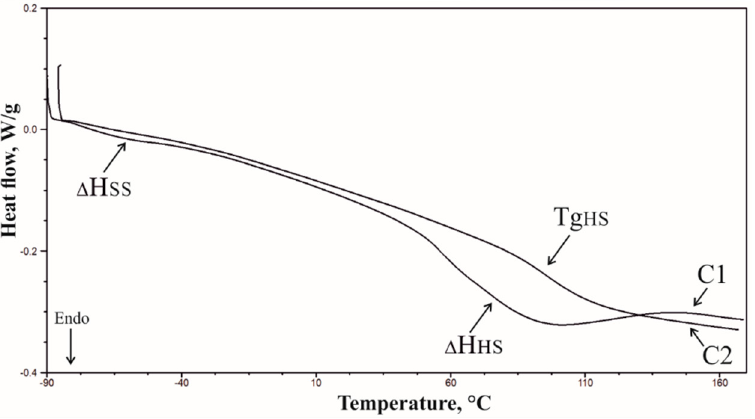
Figure 7. DSC thermogram of the PU/20 HGO A material.